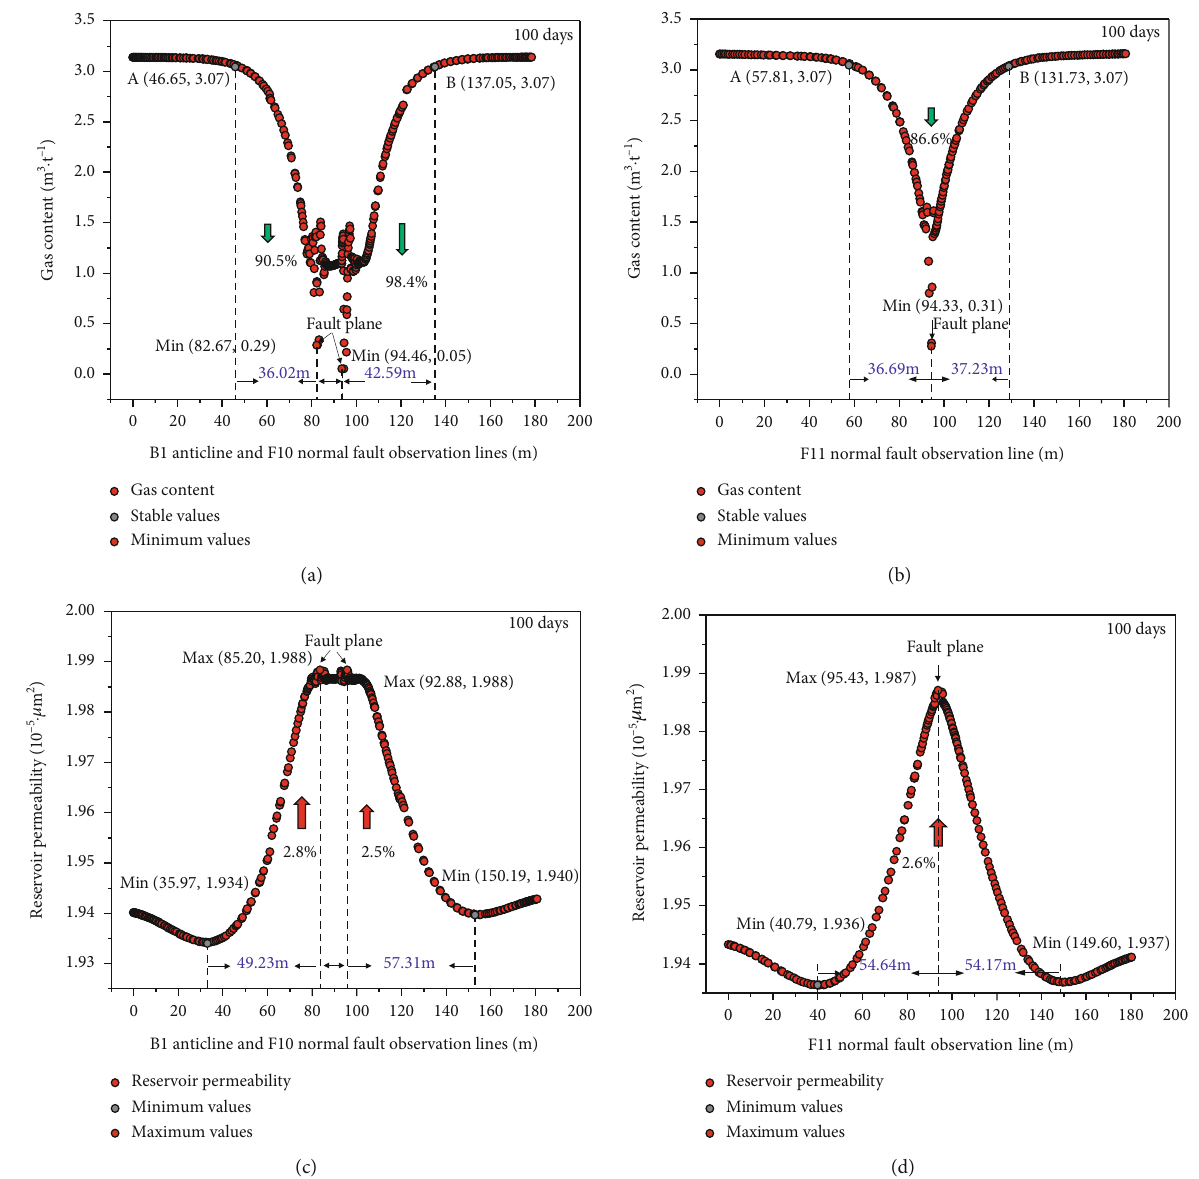
Figure 11: Variation of gas content and permeability of coal reservoirs near di ff erent tectonic positions: (a) variation of coalbed gas content near the B1 anticline and F10 normal fault; (b) variation of coalbed gas content near the F11 normal fault; (c) variation of permeability of the coal reservoir near the B1 anticline and F10 normal fault; (d) change in permeability of the coal reservoir near the F11 normal